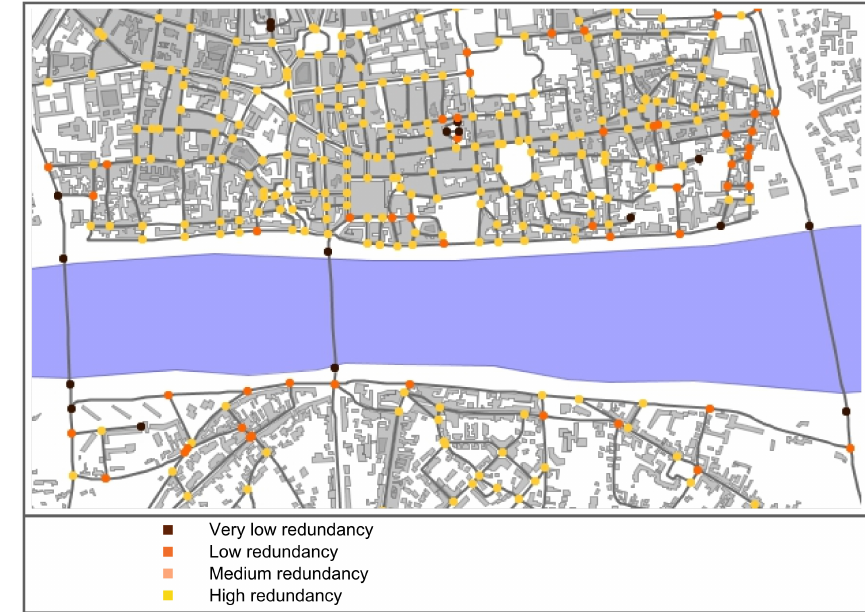
Fig. 6. Orleans road networks redundancy analysis shows the weak redundancy of this network close to